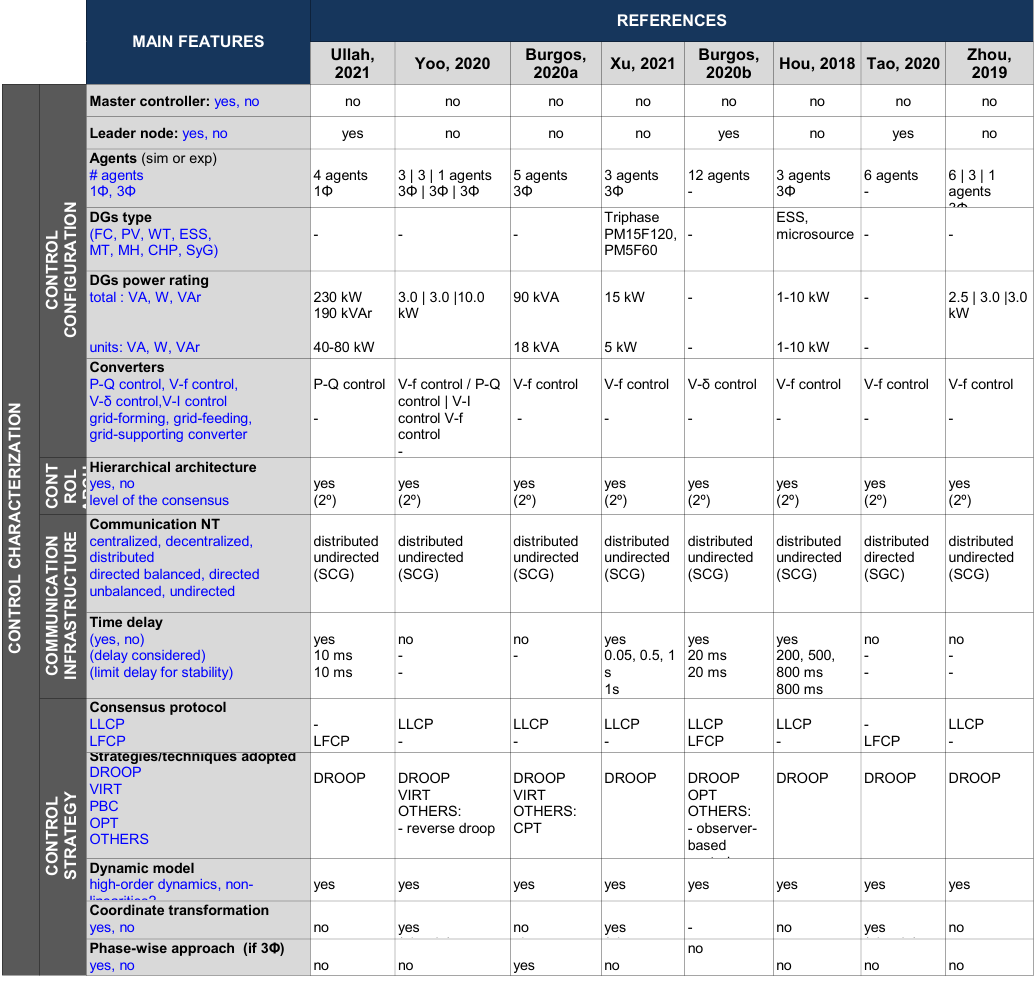
Figure 13. Publications on consensus-based control systems for MGs: control